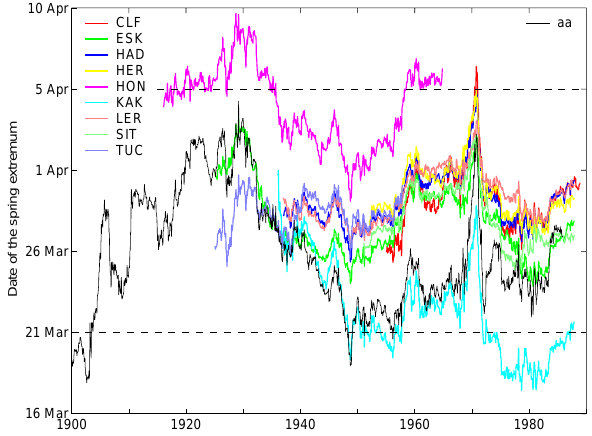
Fig. 5. Time variation of the phase of the semiannual variation of the X -component in nine observatories, computed using a 22-year sliding window, centered. The phase of the aa -index semiannual variation, computed using the same window, is also represented. Phases are reckoned as the dates of the spring